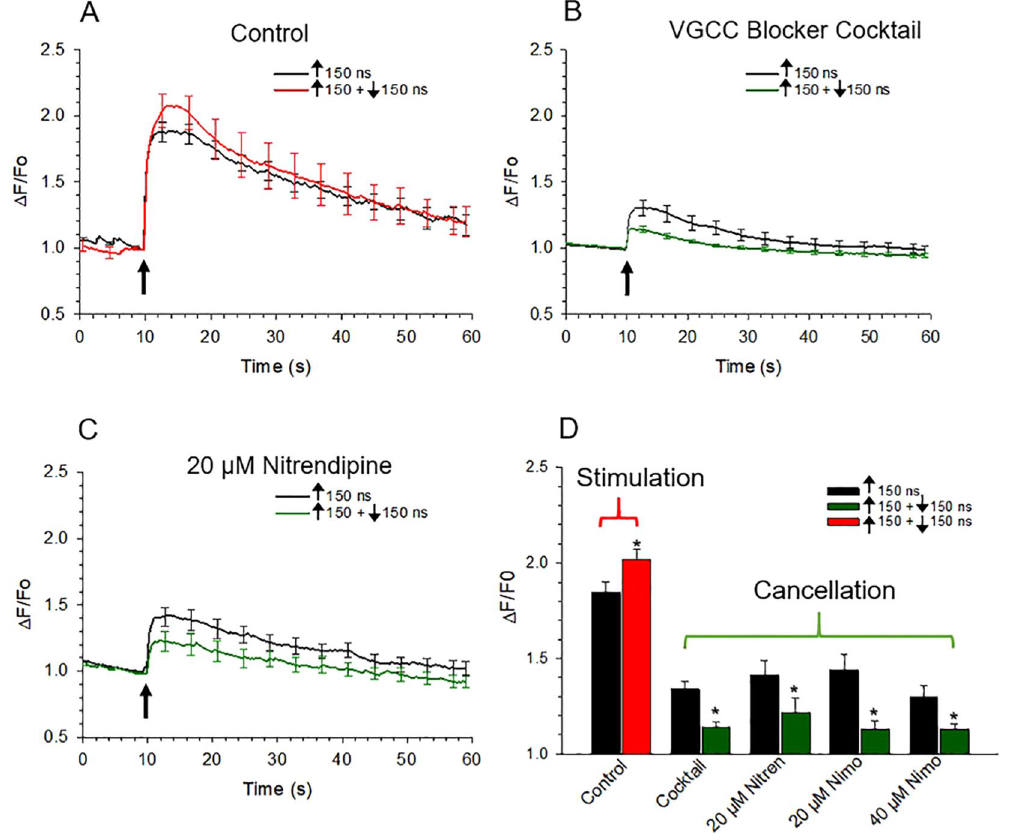
Figure 9. Effect of blocking VGCCs on Ca 2 + responses elicited by symmetrical bipolar pulses. Averaged cell responses ± s.e.m for cells exposed to a 150 ns unipolar pulse vs a ↑ 150 + ↓ 150 ns symmetrical bipolar pulse with all pulse phases set to 3.1 kV/cm. Ca 2 + responses were monitored in cells in the absence of VGCC blockers ( A ) Control (n = 8–6), or in the presence of a ( B ) cocktail of VGCC blockers containing 100 nM ω -agatoxin, 20 nM ω -conotoxin and 20 µ M nitrendipine (n = 18–25) or ( C ) 20 µ M nitrendipine (n = 32–34). The arrow indicates when the pulse was delivered to the cells. ( D ) Bar graph showing the mean ± s.e.m. for the maximal increase in [Ca 2 + ] i elicited by a 150 ns unipolar pulse vs a ↑ 150 + ↓ 150 ns symmetrical bipolar pulse in the absence or presence of the VGCC blocker cocktail, 20 µ M nitrendipine (Nitren) or 20 μ M (n = 13–10) or 40 μ M (n = 9–9) nimodipine (Nimo). Cells were pre-treated with the blockers for 1 hr at room temperature. * p < 0.05, significantly different from the corresponding unipolar